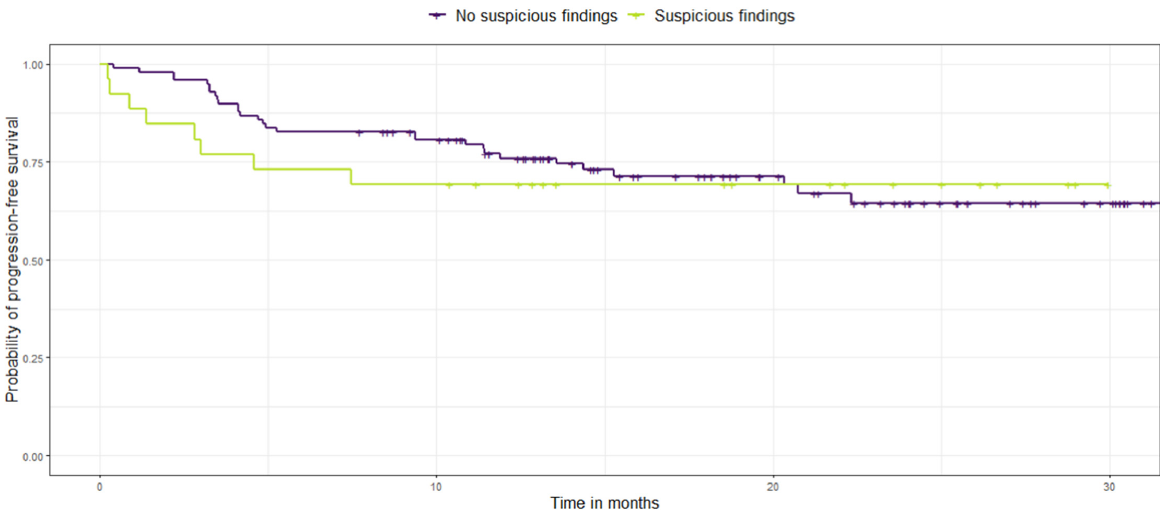
Figure 8. Kaplan-Meier survival curves display the probability of progression-free survival (in months) in NSCLC patients with additional suspicious findings (lemon green) versus no suspi- cious findings (purple).